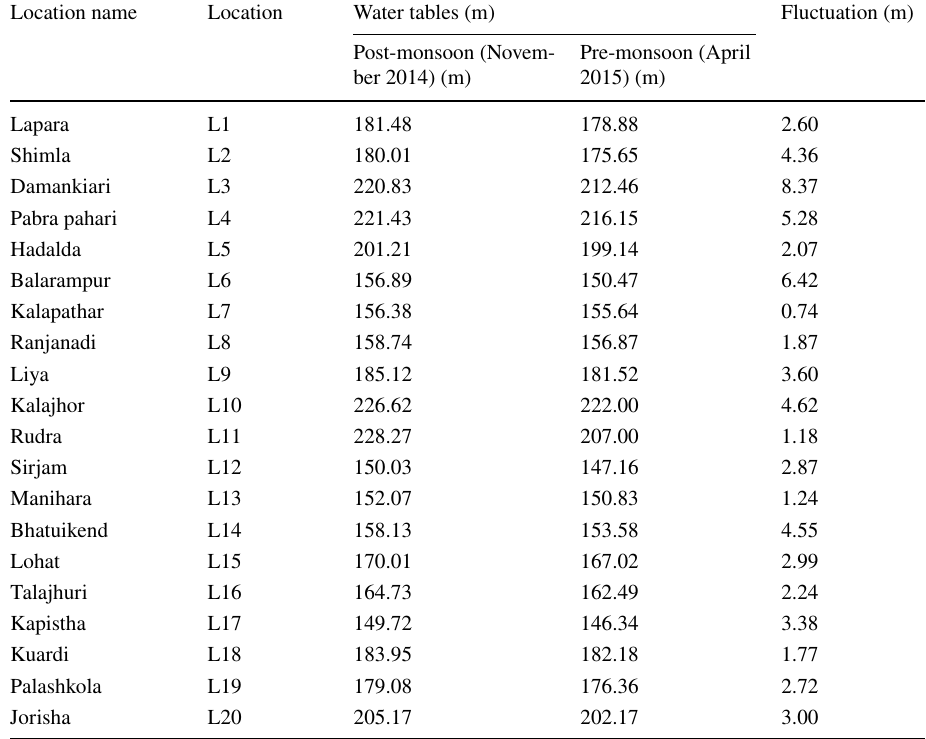
Table 1 Water tables with regard to bore wells